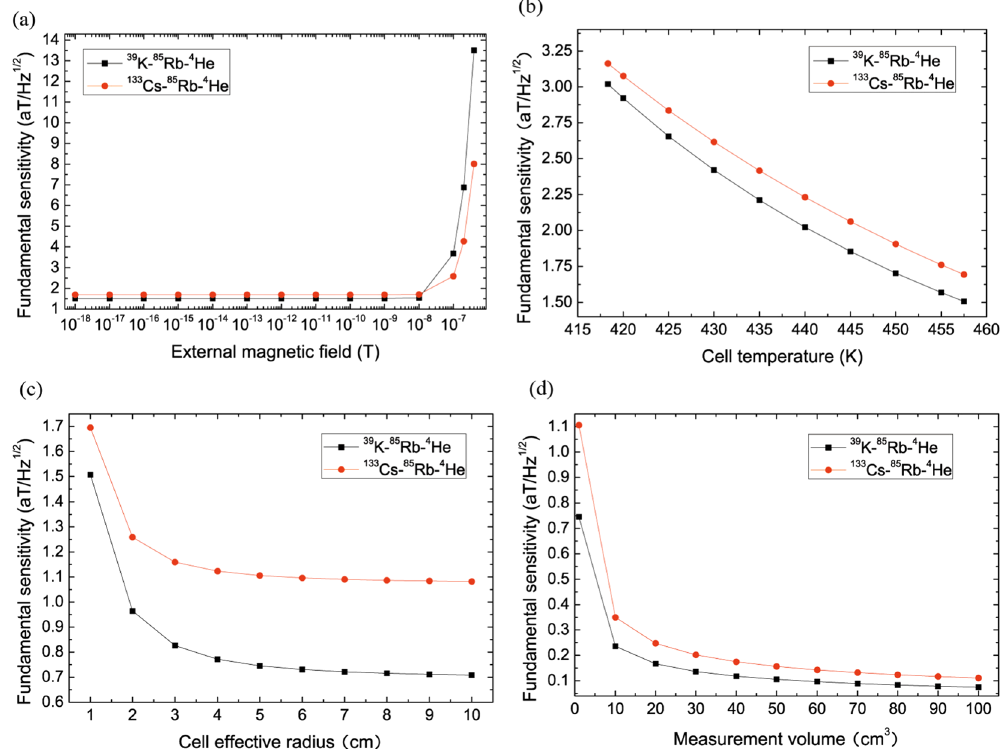
Figure 5. The fundamental sensitivity of 39 K ( 133 Cs)- 85 Rb- 4 He magnetometers varies with the external magnetic field, cell temperature, cell effective radius and measurement volume. ( a ) When the external magnetic field is smaller than about 10 − 8 T , the fundamental sensitivity of 39 K ( 133 Cs)- 85 Rb- 4 He magnetometers almost do not vary with the increasing external magnetic field respectively. ( b ) The fundamental sensitivity of 39 K ( 133 Cs)- 85 Rb- 4 He magnetometers increase with the increasing cell temperature respectively. ( c ) The fundamental sensitivity of 39 K ( 133 Cs)- 85 Rb- 4 He magnetometers increase with the increasing cell effective radius respectively. ( d ) The fundamental sensitivity of 39 K ( 133 Cs)- 85 Rb- 4 He magnetometers with a = 5 cm increase with increasing measurement volume